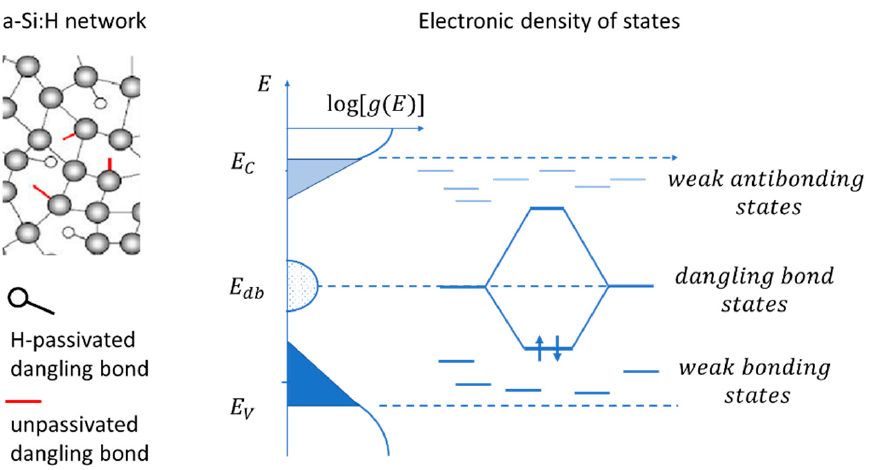
Figure A4. Mechanical strain on Si-Si nearest neighbor bonds reduces the bonding–antibonding gap and causes conduction and valence band states to become localized into exponential conduction and valence band tails (triangular areas). Depending on electron (hole) availability, weak bonds can decay into pairs of dangling bonds with localized states near mid-gap.